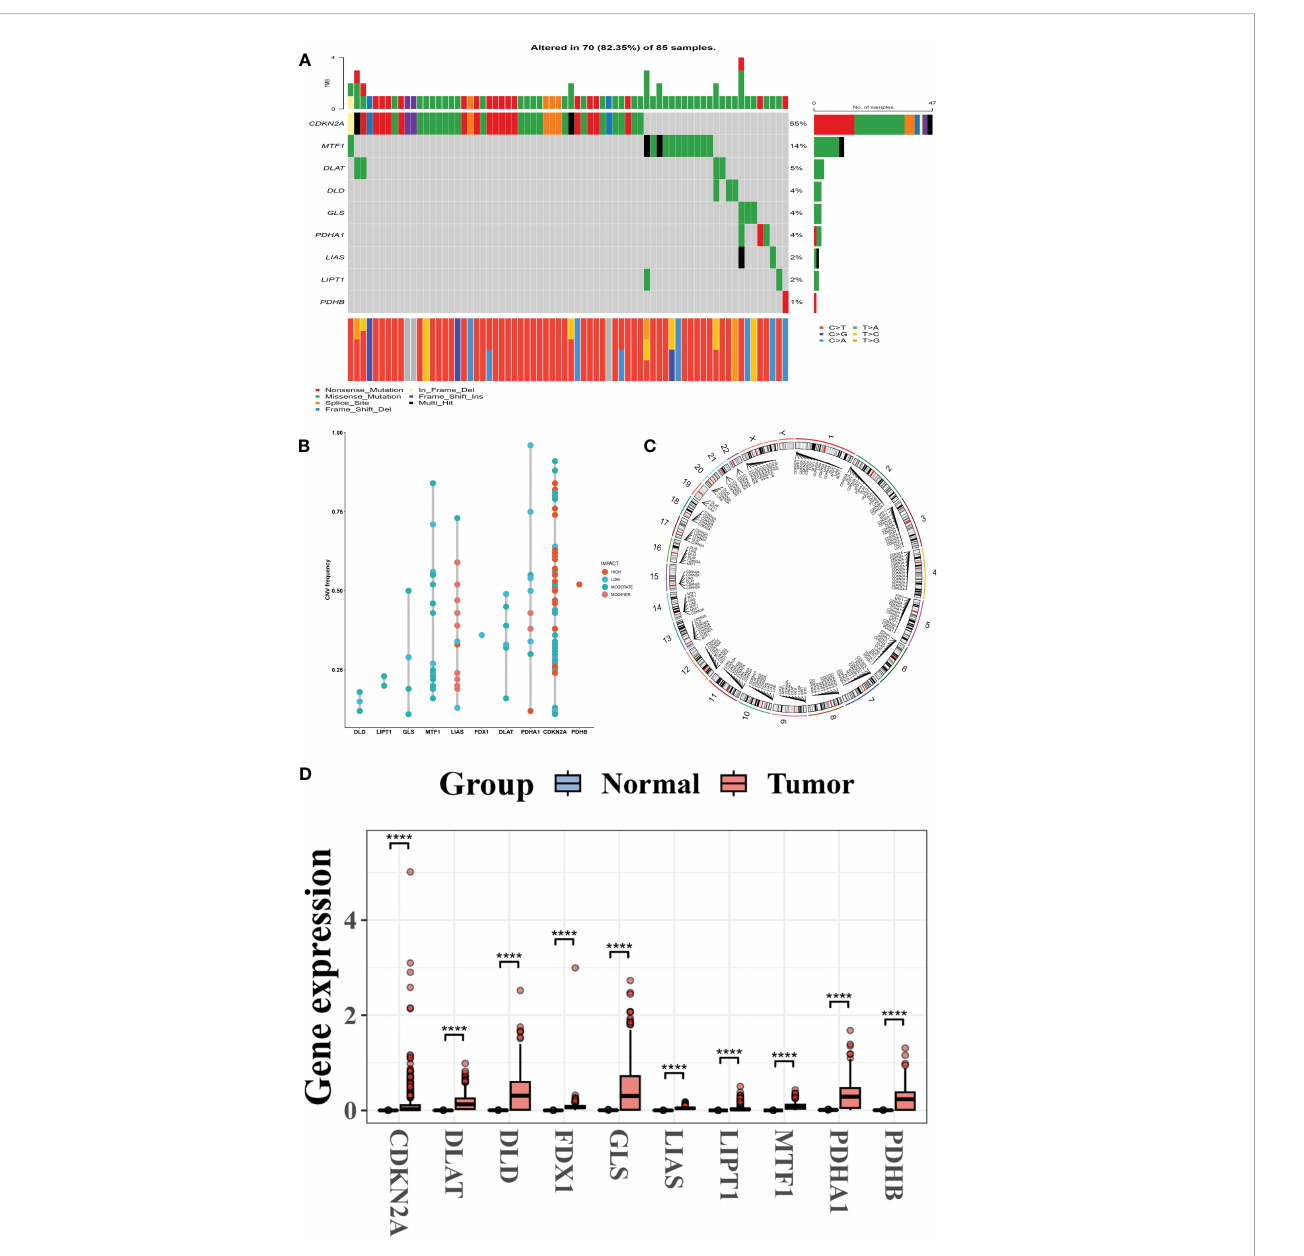
FIGURE 2 CRG genetic and transcription factors alterations in melanoma. (A) Mutation frequency range of ten CRGs in 85 SKCM cohorts from the TCGA patient. (B) Frequencies of CNV in high, low, moderate, and modi fi er CRGs. (C) CNV alterations in CRGs on 23 chromosomes. (D) Expression patterns of ten CRGs in normal and melanoma tissues. CRGs, Cuprotosis-related genes; SKCM, Skin Cutaneous Melanoma; TCGA, The Cancer Genome Atlas; CNV, copy number